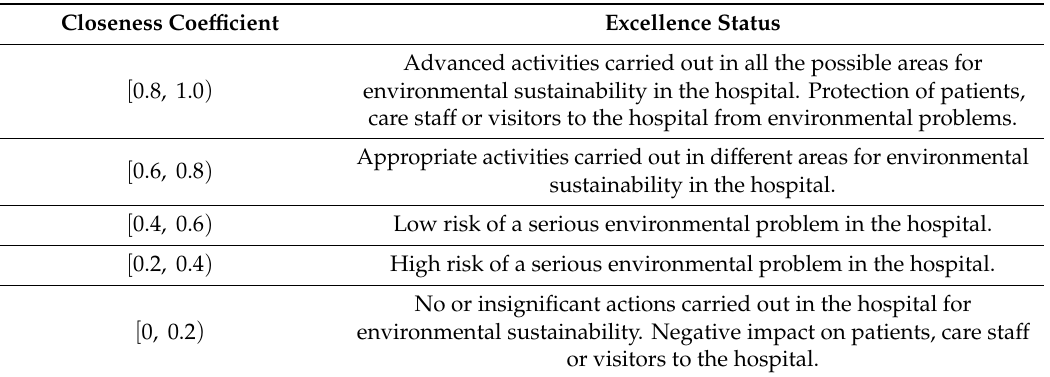
Table 11. Excellence